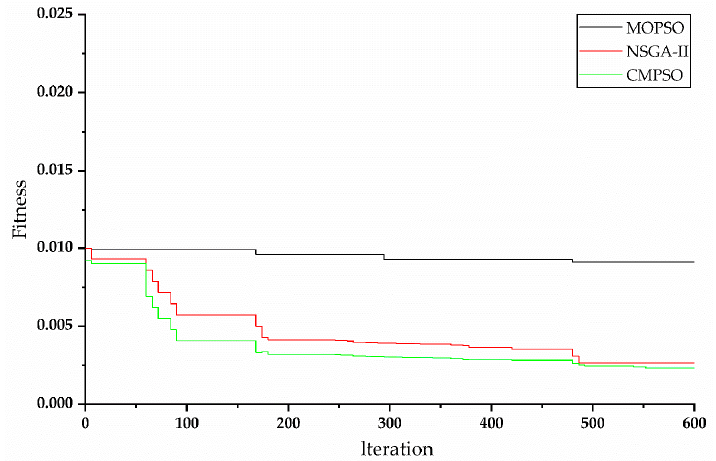
Figure 5. Comparative fitness of the three algorithms.